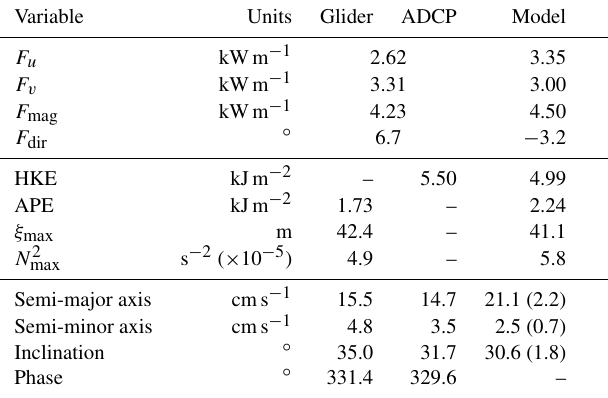
Table 1. Comparison between observed (glider and ADCP) D 2 and modelled M 2 internal tide and surface tidal ellipse diagnostics. Modelled ellipse values are averaged (mean) over the 48 grid points in the area that contains all the glider dives deeper than 500m (see Fig. 5d). The values in brackets are standard deviations. All bear- ings are anticlockwise from